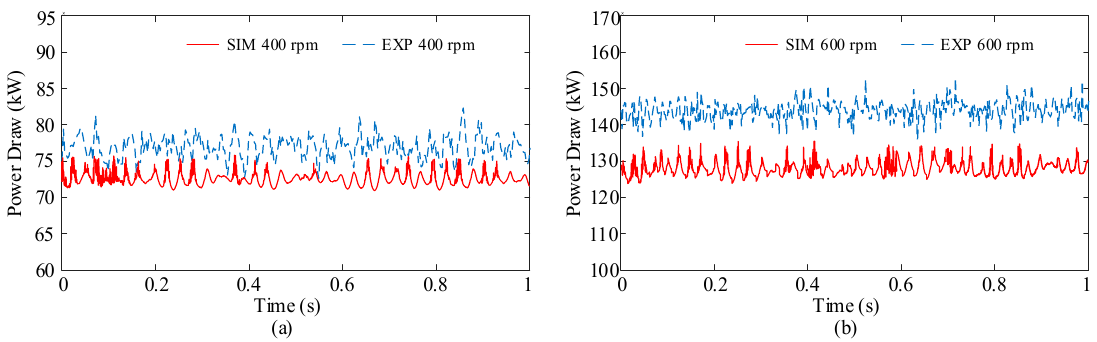
Figure 17. The curve displays a comparison between simulated and measured output power for 1 s of operation: ( a ) 400 rpm and ( b ) 600 rpm. operation: ( a ) 400 rpm and ( b ) 600